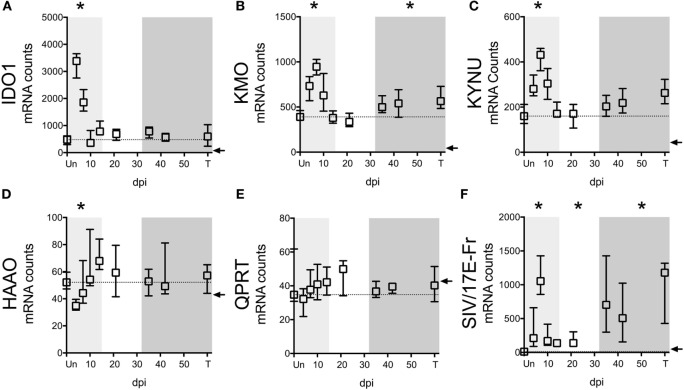
IDO1 transcriptional regulation mirrors kynurenine (KYN)/tryptophan (TRP) induction in spleens of SIV-infected pigtailed macaques. mRNA was harvested from spleens of 58 animals euthanized at various points following SIV infection and analyzed for transcriptional expression of SIV RNA and enzymes in the QUIN/NAD+ producing axis of the IDO1 pathway of TRP metabolism. (A) Expression of IDO1, which mediates the oxidative cleavage of the pyrrole ring of TRP to form l-formylkynurenine, the precursor to KYN. (B) Expression of kynurenine 3-monooxygenase (KMO), also known as kynurenine 3-hydroxylase, which adds a hydroxyl group to KYN to generate 3HK. (C) Expression of kynureninase (KYNU), which catalyzes the hydrolytic cleavage of 3HK to form 3HANA and also catalyzes the cleavage of KYN to form anthranilic acid. (D) Expression of 3-hydroxyanthranilate-3,4-dioxygenase (HAAO; also known as 3HAO), which oxidatively cleaves the ring of 3HANA to form 2-amino-3-carboxymuconic semialdehyde, the precursor to QUIN. (E) Expression of quinolinate phosphoribosyltransferase (QPRT), which mediates the conversion of quinolinic acid into NAD+. (F) Expression of SIV/17E-Fr Gag RNA. The dotted lines in graphs (A–E) represent the medians of uninfected controls. Arrows represent the background threshold of the assay. Asterisks (*) represent time points that are significantly different (p < 0.05) from uninfected values by Kruskal–Wallis with Bonferroni correction.